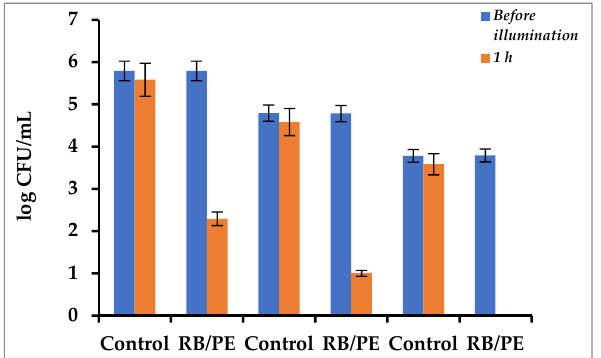
Figure 6. Effect of the initial S. aureus cell concentration on the antibacterial activity of 1% RB/PE at a loading of 10 g/L under illumination with 1.25 mW/cm 2 white light.